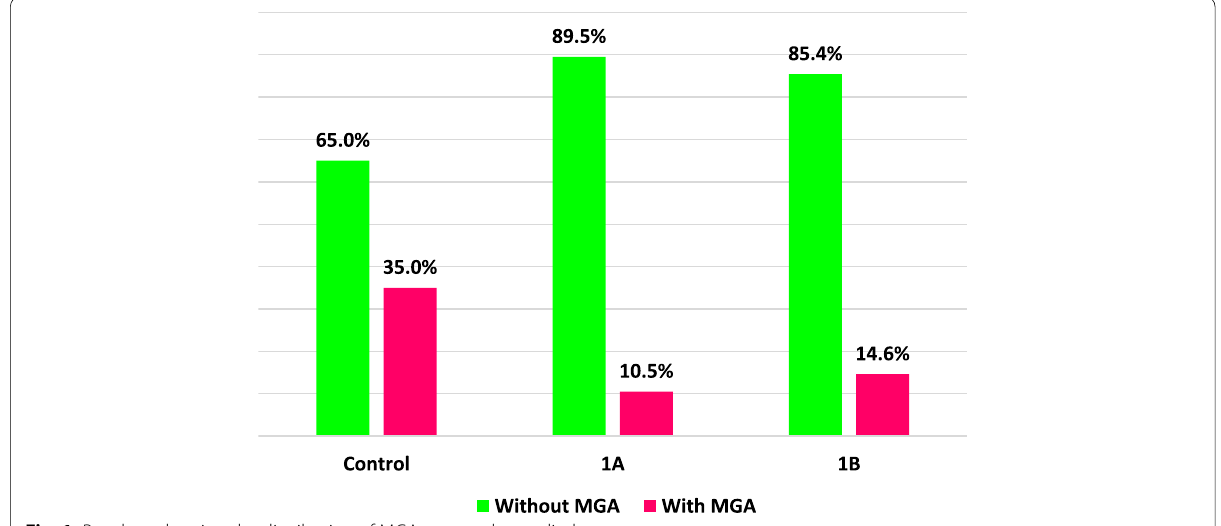
Fig. 1 Bar chart showing the distribution of MGA among the studied